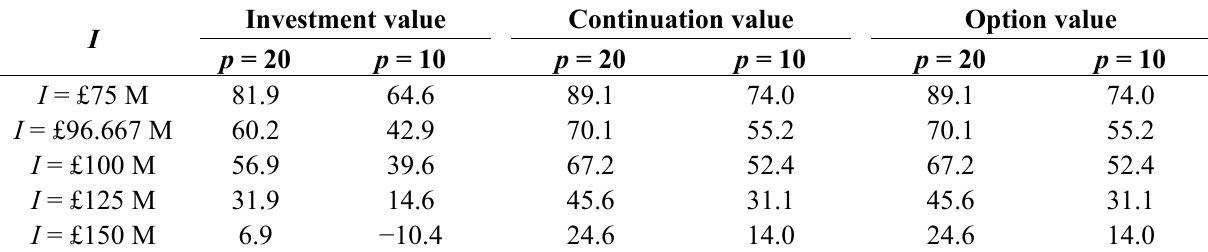
Table 16. Option value (£M) under electricity price plus a premium.